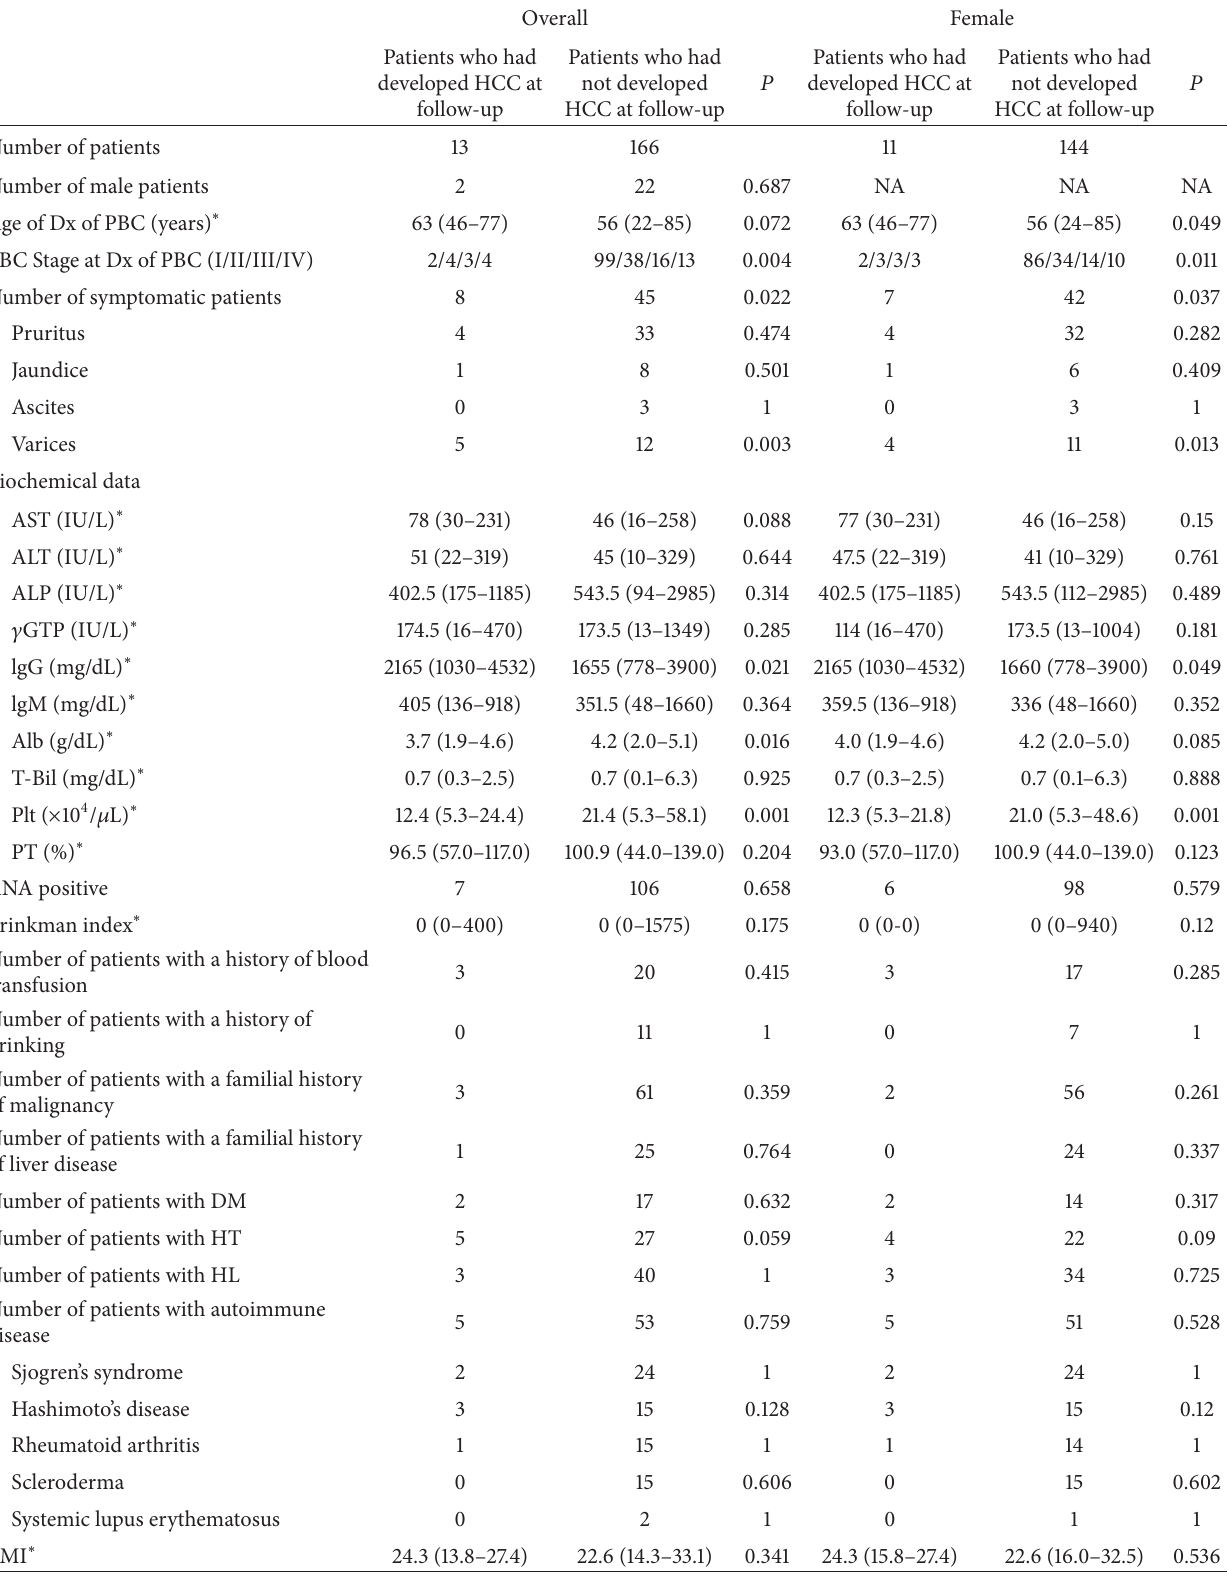
Table 2: Comparison of clinicopathological characteristics between patients who had developed hepatocellular carcinoma (HCC) and those who had not developed HCC at follow-up.